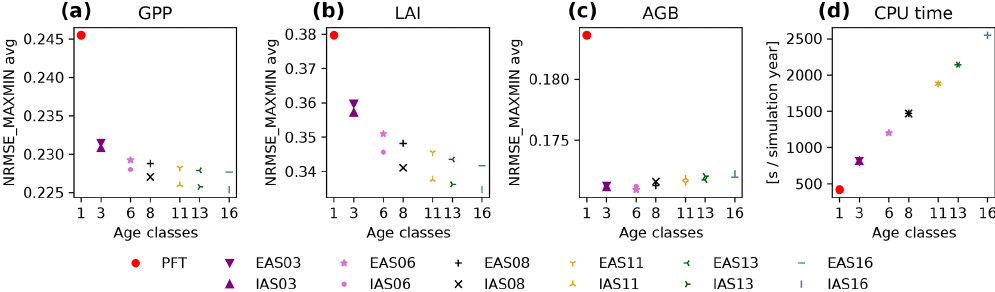
Figure 6. Change in the normalised root mean squared error (NRMSE Max − Min , Sect. 2.3.5) and in the CPU time when increasing the number of age classes. Panels (a) to (c) show the averaged NRMSE Max − Min (see also Fig. 5). Averaging has been conducted giving equal weights to all selected regions (Sect. 2.3.5) for AGB (c) and in addition to all four seasons for GPP and LAI (a, b) . Figure S3.1 in the Supplement shows the same data separately for each region. Panel (d) shows the computation time required per simulation year averaged over the years